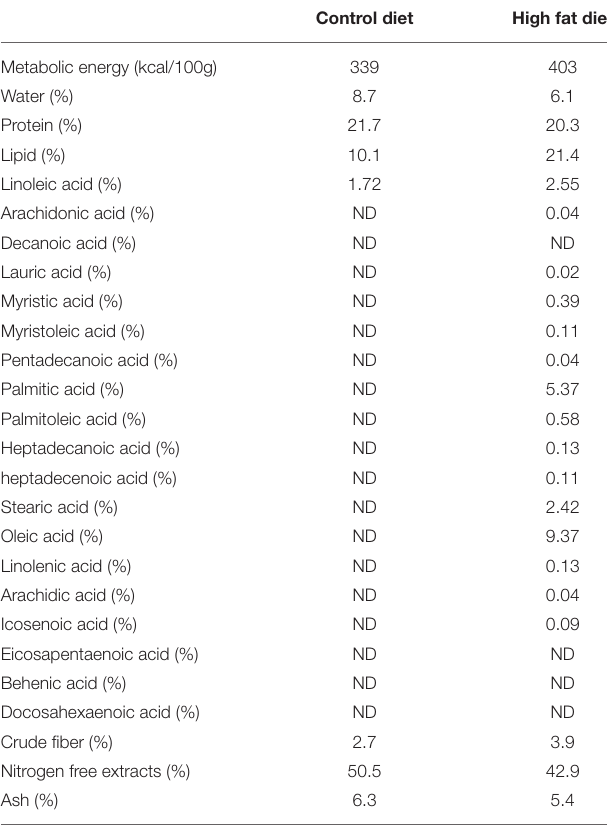
TABLE 1 | Comparison of compounds between control and high fat